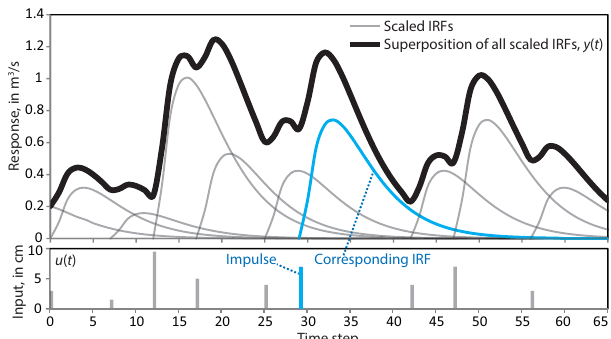
Figure 1. Superposition of sequential impulse-response functions (IRFs). Each IRF is in response to an impulse of the input function u j and is scaled by the magnitude of that